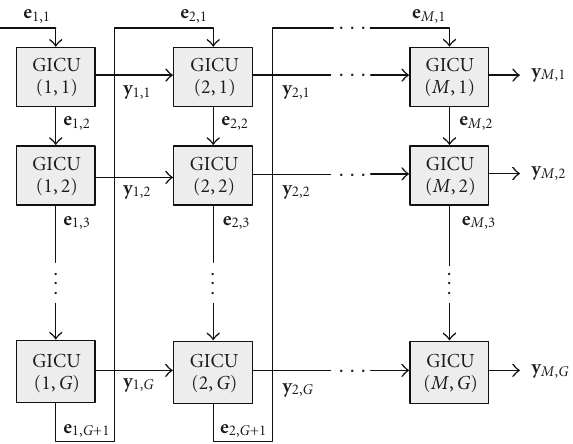
Figure 1: Multistage structure of the chip-level linear BSOR-GSIC detector.